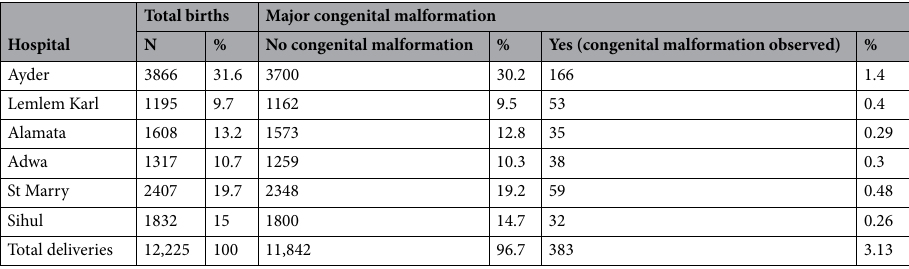
Table 1. Hospital based prevalence of major congenital malformations in Tigray, Northern Ethiopia, 2019 (n = 12,225). Percentages were calculated by taking the corresponding “total number” as denominator.